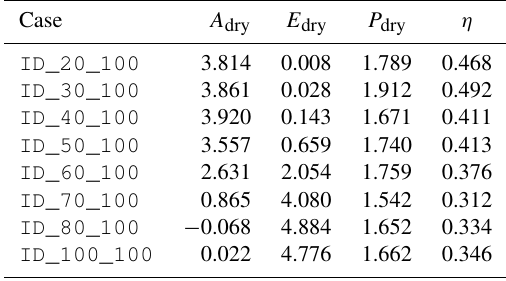
Table 3. As in Table 2 but for the ID sounding.